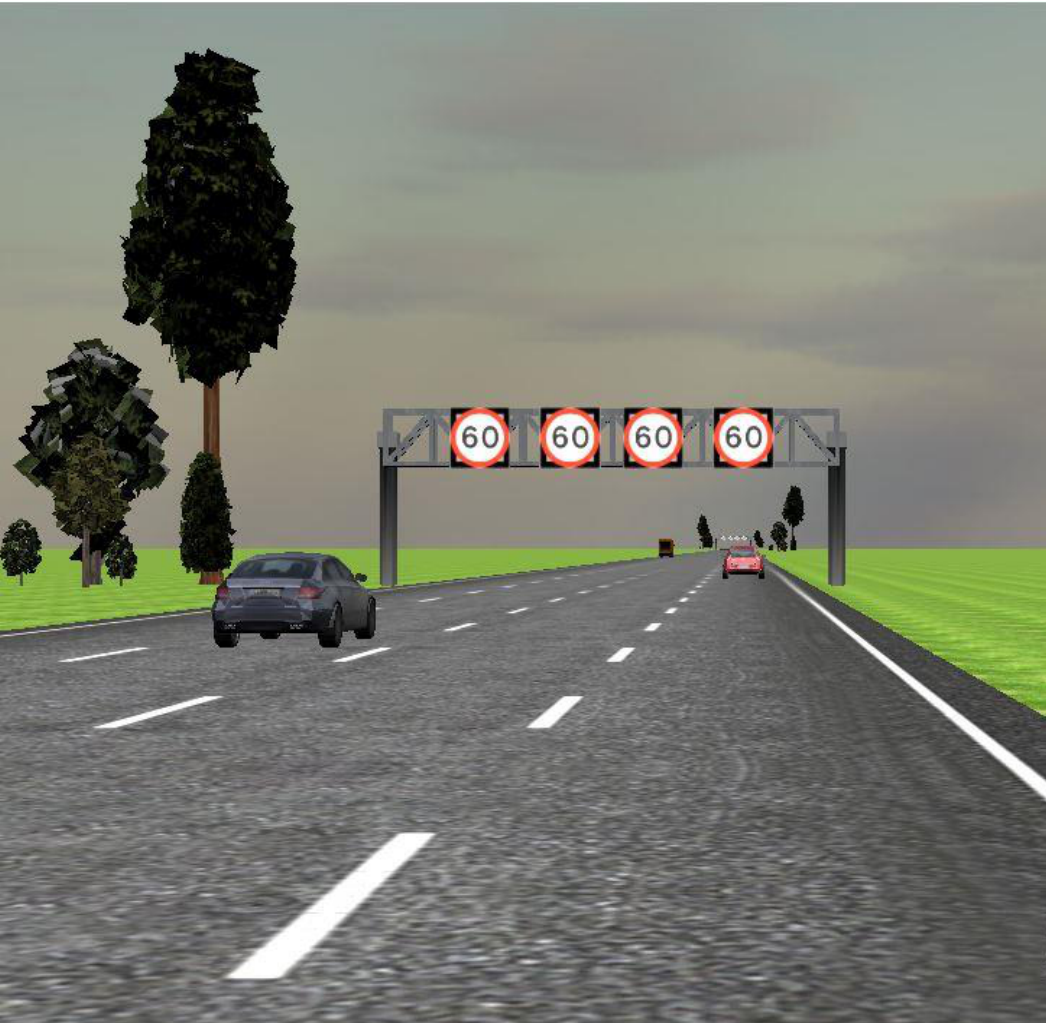
Figure 1 . Illustration of the virtual road environment in the baseline noHMI condition . Figure 1. Illustration of the virtual road environment in the baseline noHMI